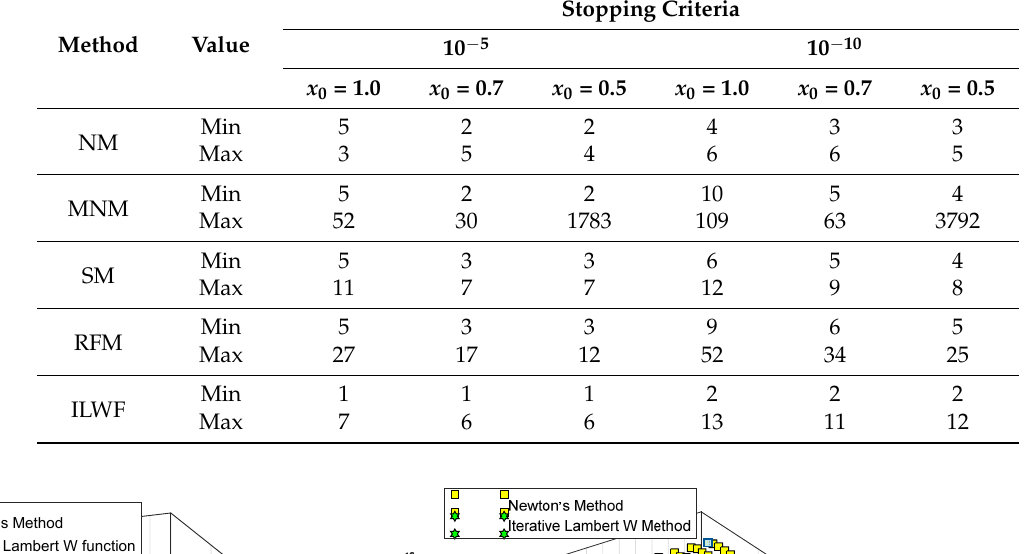
Table 8. Minimum and maximum number of iterations for the used iterative methods observing the measured points of the TDM representing the RTC France solar cell. Stopping Criteria Method Value 10 − 5 10 − 10 x 0 = 1.0